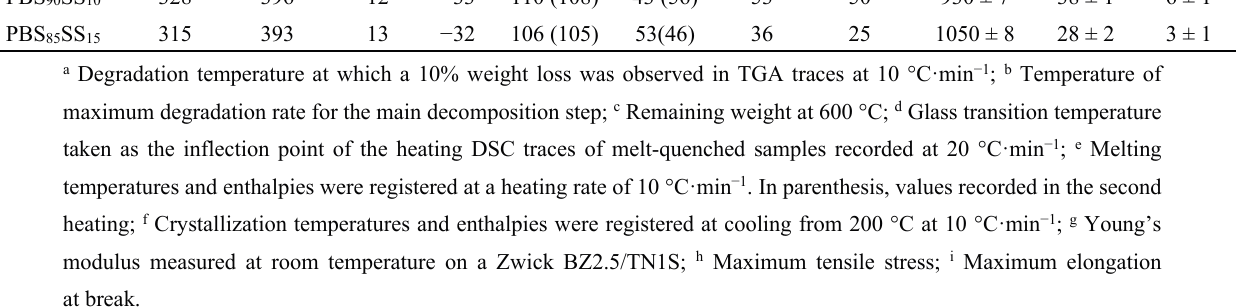
Figure 2. (a ) TGA traces of PBS1 and PBS SS copolyesters. PBS x y Table 2. Thermal and mechanical properties of PBS homopolymer and PBS TGA DSC Stress-strain Copolyester